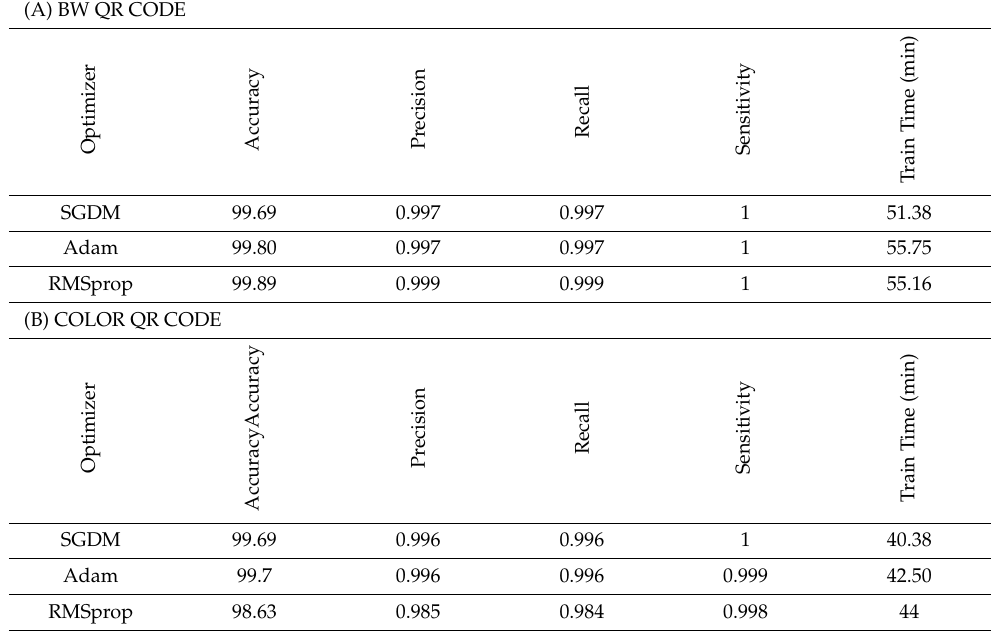
Table 11. Performing metrics for the customized residual